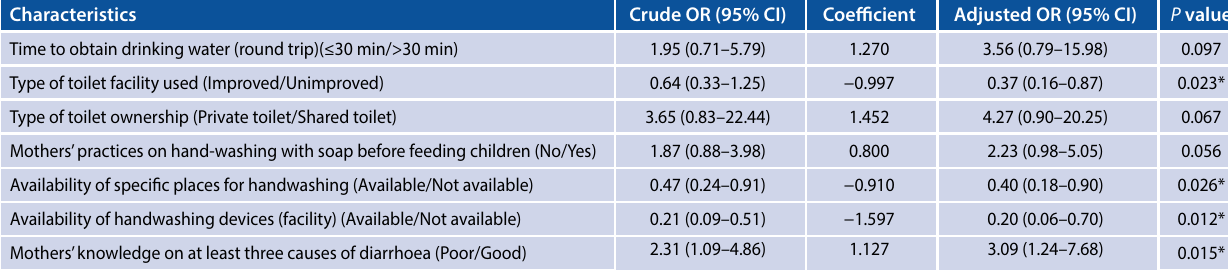
*Statistically significant with p value ≤